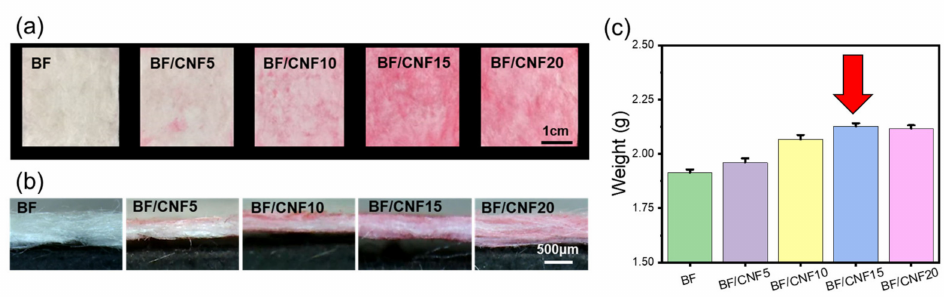
Figure 4. Effect of CNF addition on the visual inspection of BF/CNF fibrous preforms. ( a , b ) Optical images of Direct Red 80 dyed BF/CNF fibrous preforms, and ( c ) weight-gain ratio